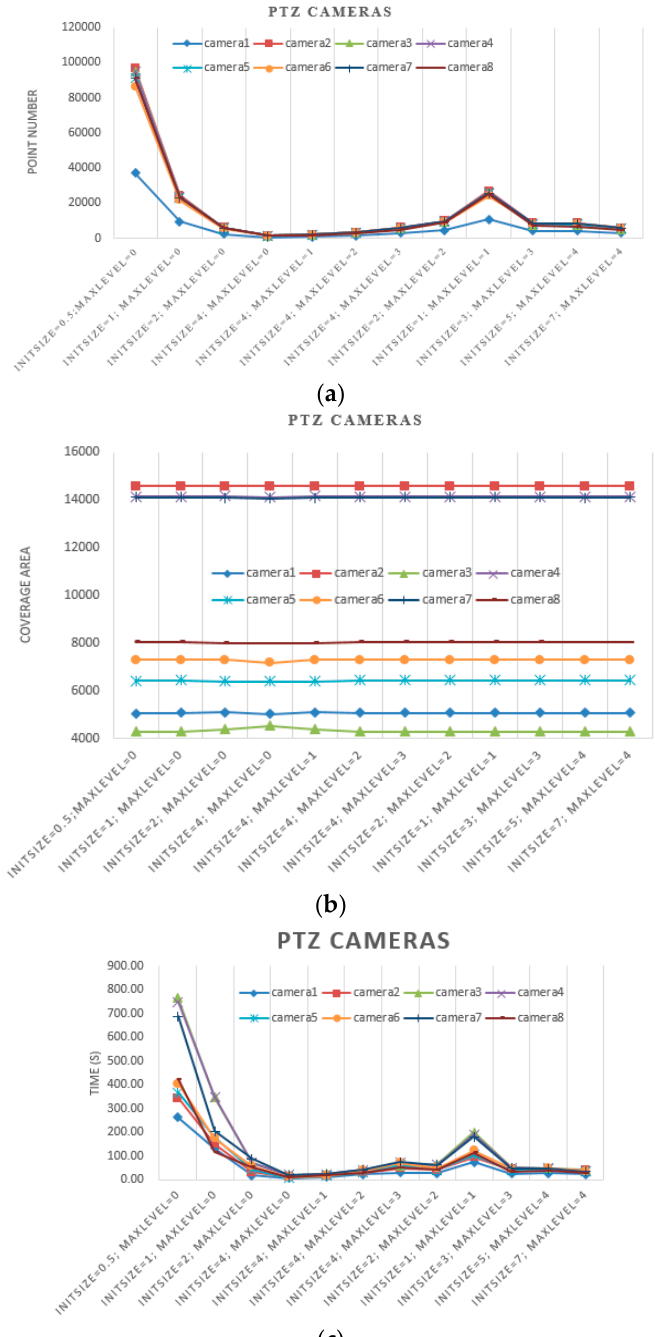
Figure 13. Results for PTZ cameras ( a ) point number; ( b ) coverage area; ( c ) time-consuming.